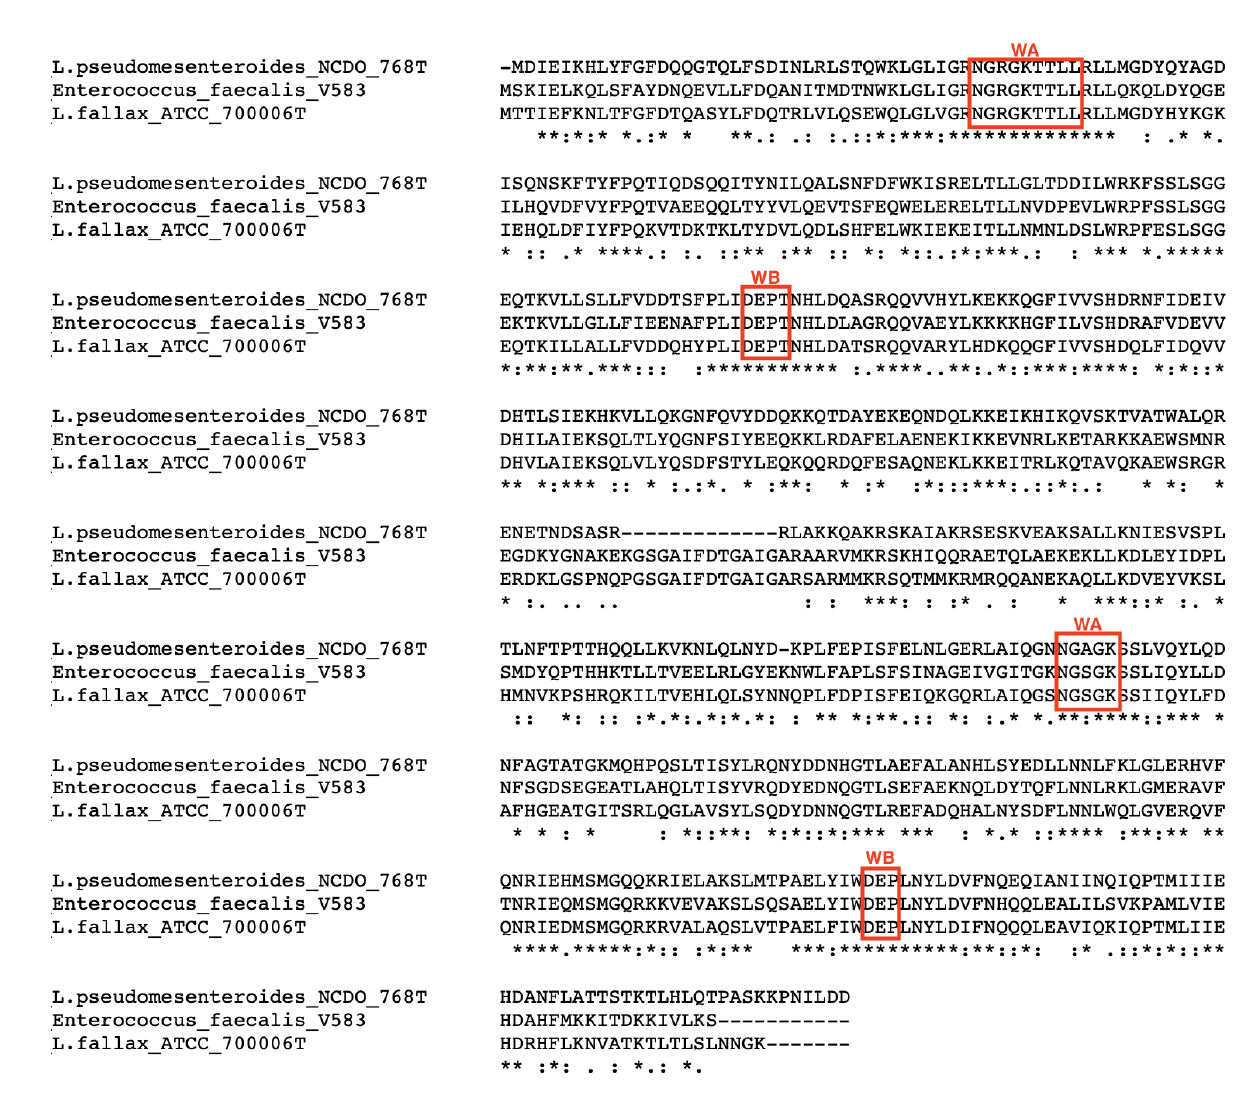
Figure 3. Alignment of LsaA amino acid sequence of L. pseudomesenteroides NCDO 768 T , L. fallax ATCC 700006 T and E. faecalis V583. The red boxes highlight the Walker A (WA) and Walker B (WB) domains conserved in the three sequences.